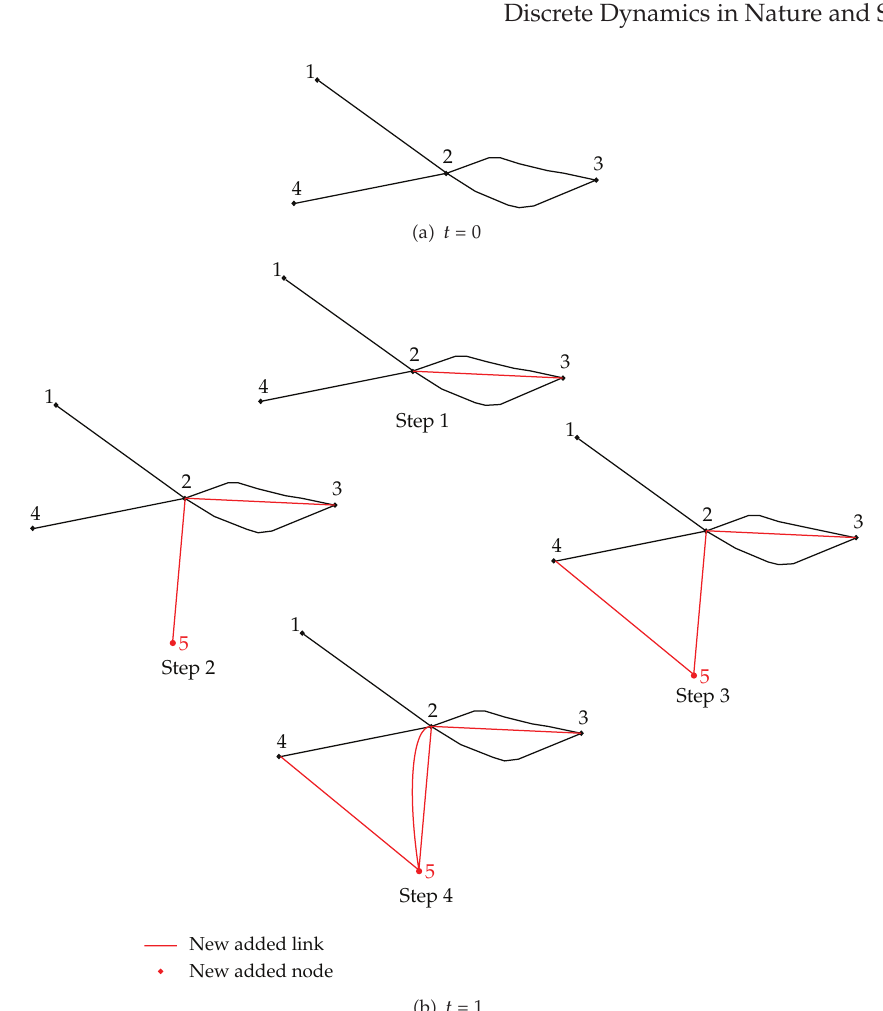
Figure 1: An illustration of the network evolving mechanism for the tra ffi c and transportation network: Assume m 0 (cid:8) 4, m (cid:8) 4, and ρ (cid:8) 0 .